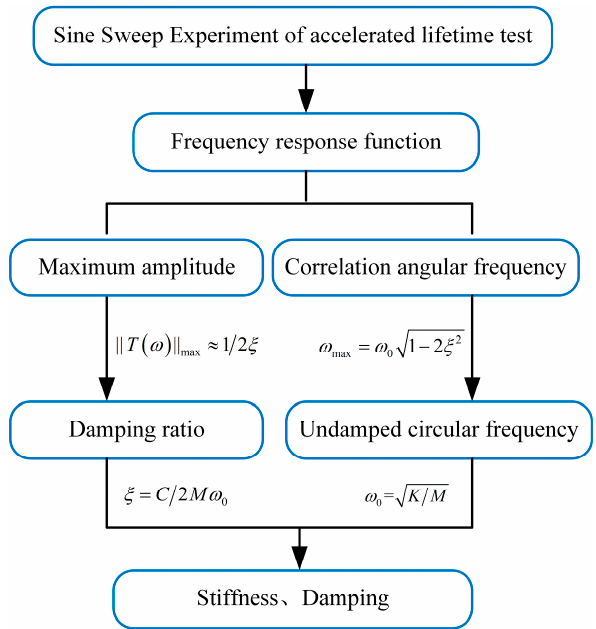
Figure 5. Stiffness and damping algorithm scheme.